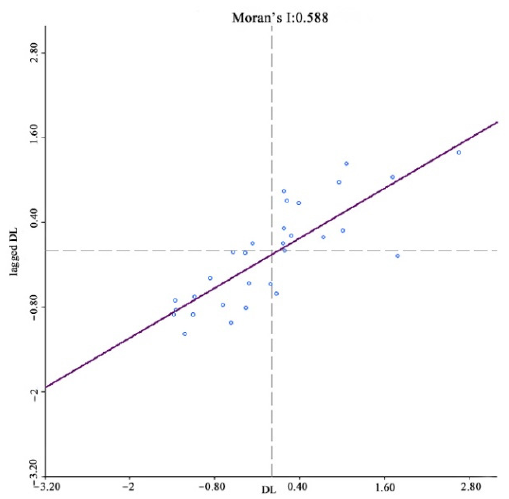
Figure 7. Global Moran’s I of usage depth growth.